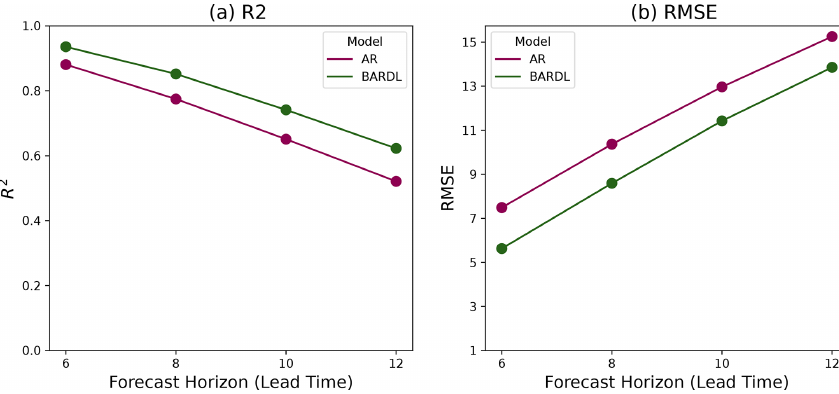
Figure 5. Performance metrics used to measure model accuracy as a function of forecast lead time. R 2 (a) , RMSE (b)